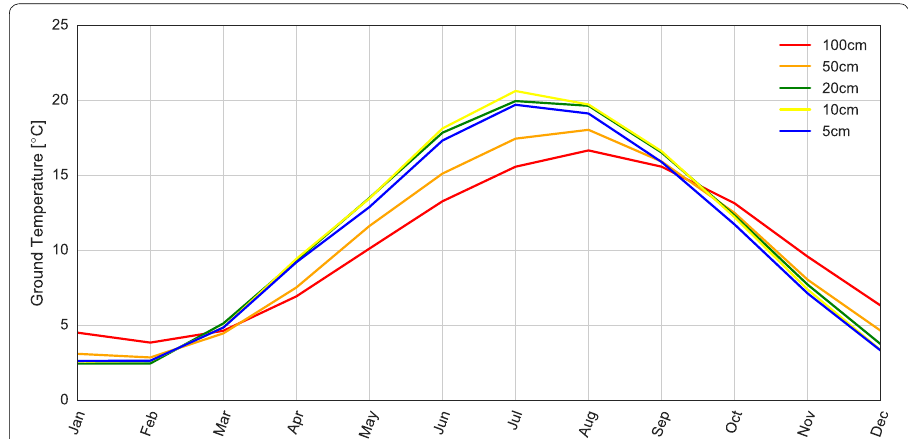
Fig. 4 Monthly ground temperature data in Switzerland. Temperatures are shown for depth of 5, 10, 20, 50, and 100 cm, and are averaged through all the measurement stations available in Switzerland